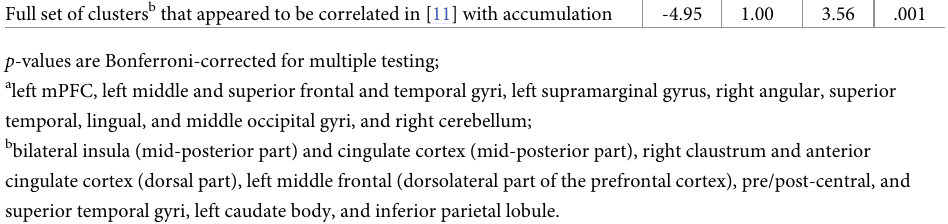
Table 1. Region of interest analyses predicting neural activity in the full set of clusters observed by Re´sibois, Ver- duyn & colleagues [11] to be correlated with emotion explosiveness (resp. accumulation). Region of interest Explosiveness Accumulation T p